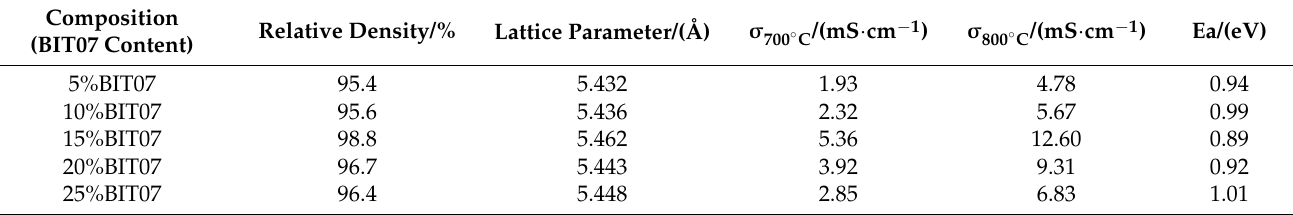
Table 1. Properties of CSYG-BIT07 composite